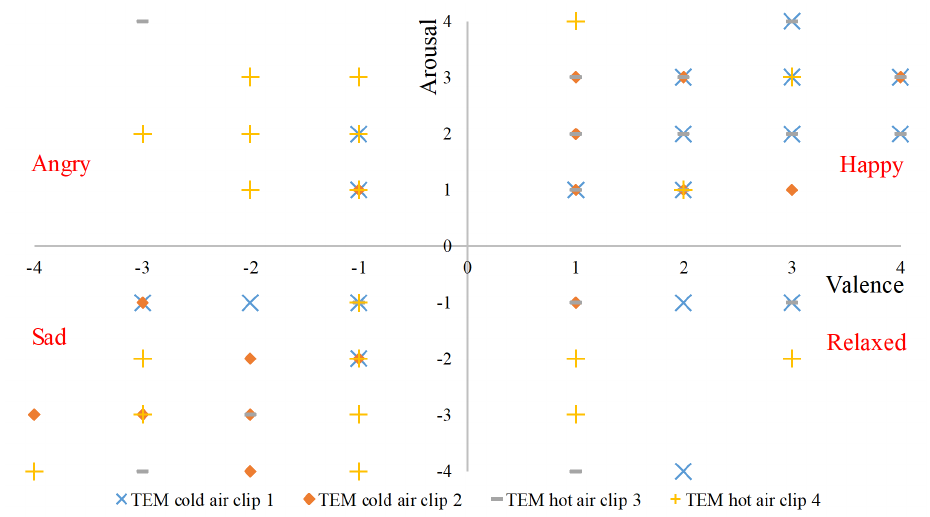
Figure 5. Recorded SAM scores in response to four TEM